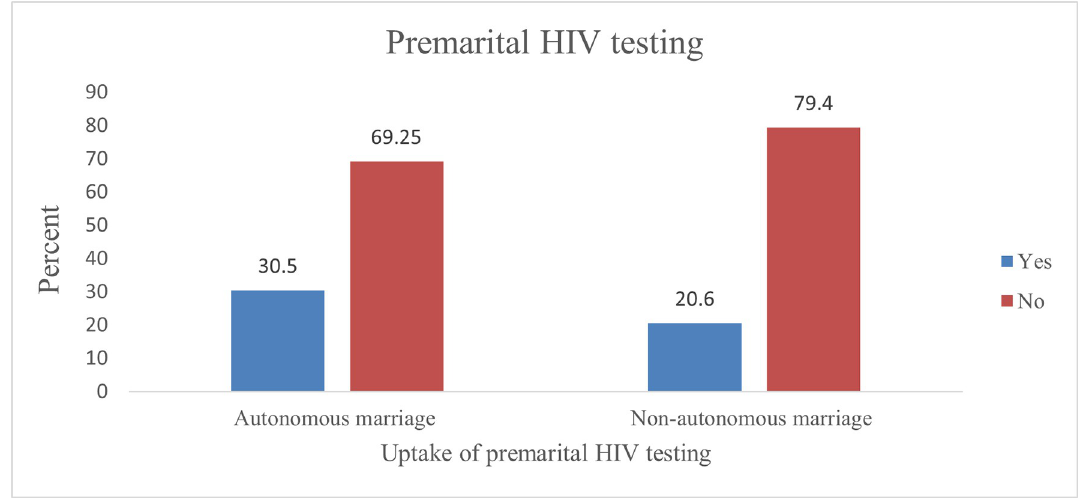
Fig 2. Uptake of premarital HIV testing among women who had autonomous versus non autonomous marriage in Ethiopia, EDHS 2016.